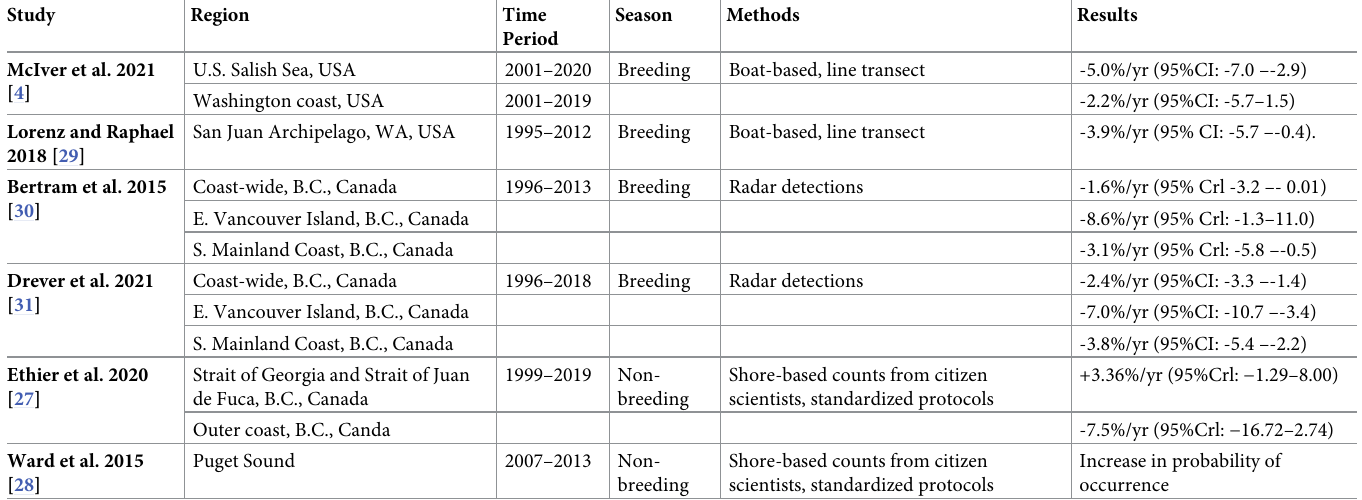
Table 2. Pacific northwest marbled murrelet trend by region, season, time-period and survey